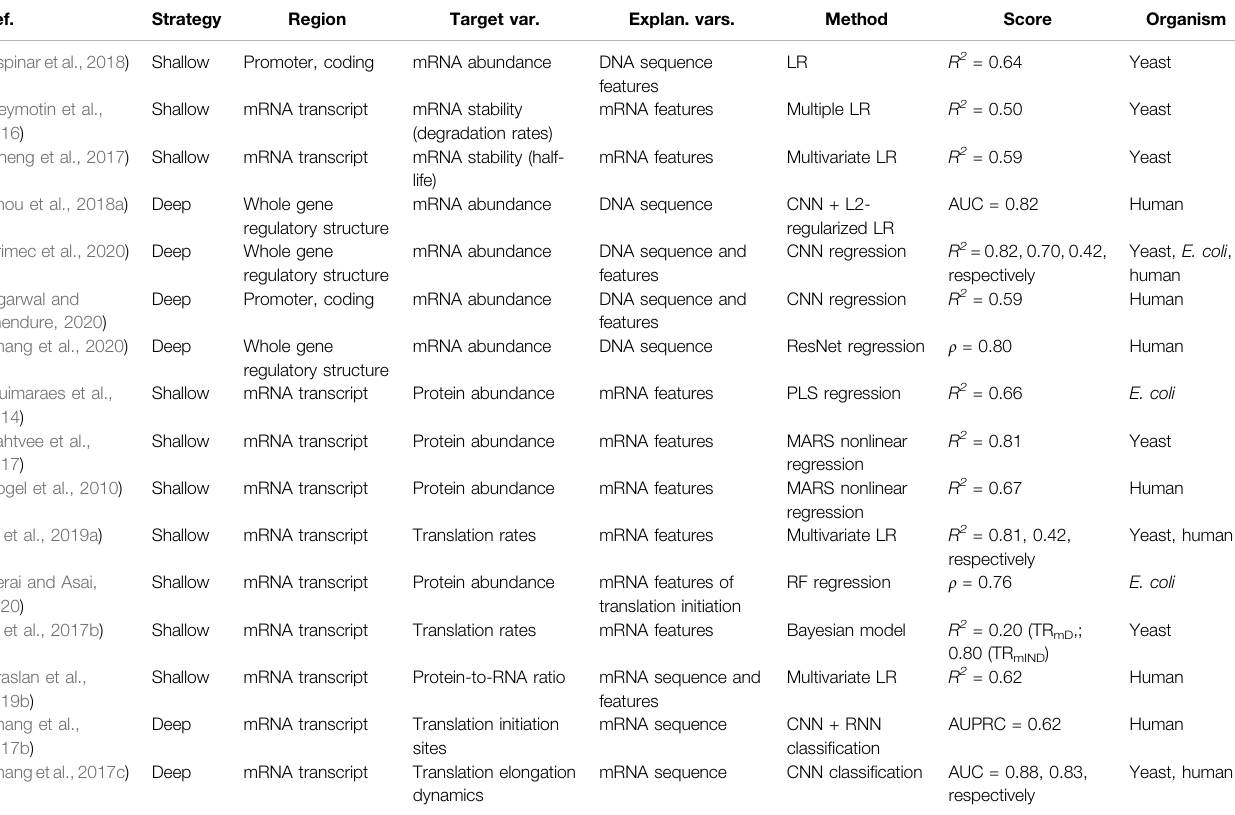
TABLE 3 | Overview of studies modeling transcript and protein-abundance related properties from combined regulatory and coding regions. Highest achieved or average scores are reported, on test sets where applicable, and include area under the receiver operating characteristic curve (AUC), area under the precision recall curve (AUPRC), the coef fi cient of variation ( R 2 ) and Spearman ’ s correlation coef fi cient ( ρ ).